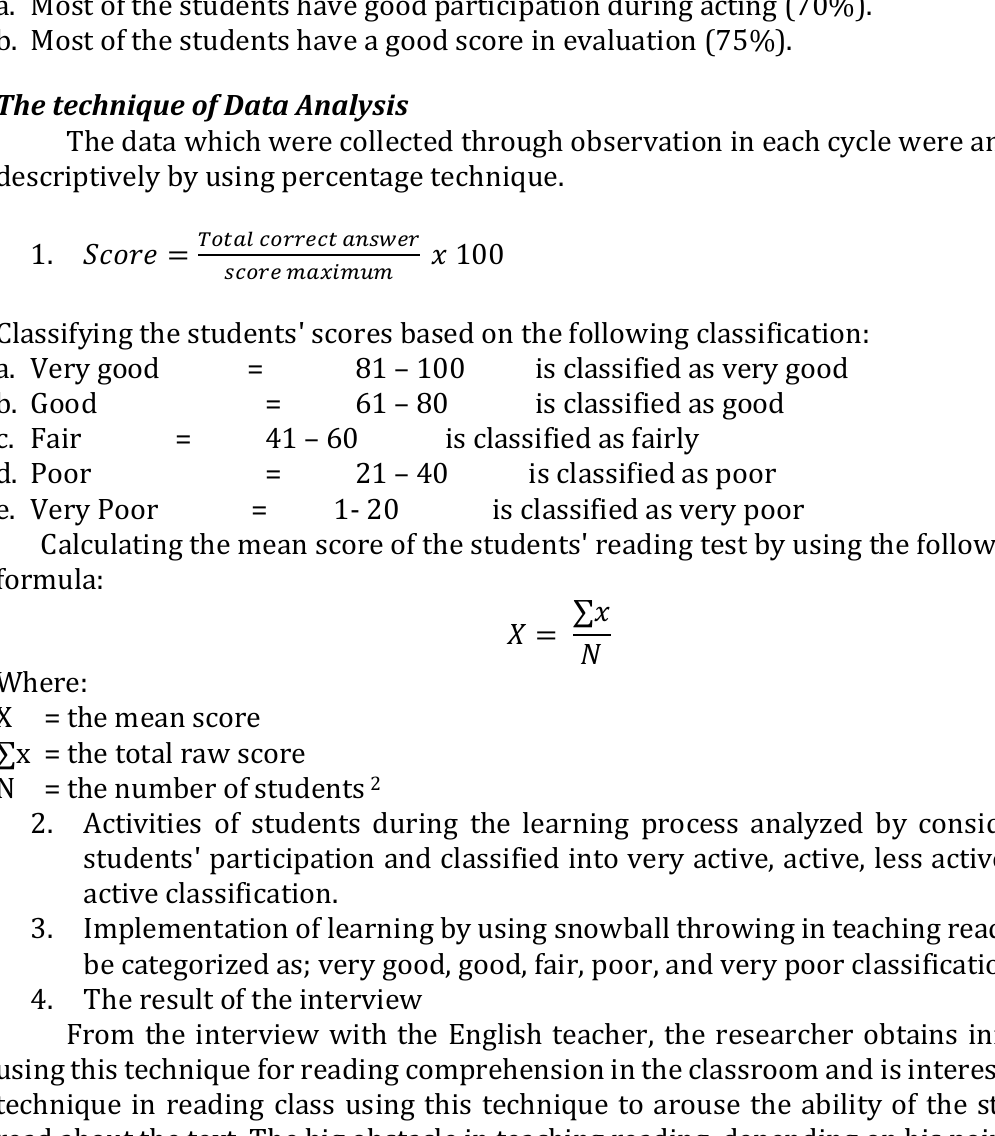
Table 1. Reading Assessment based on Brown, H.